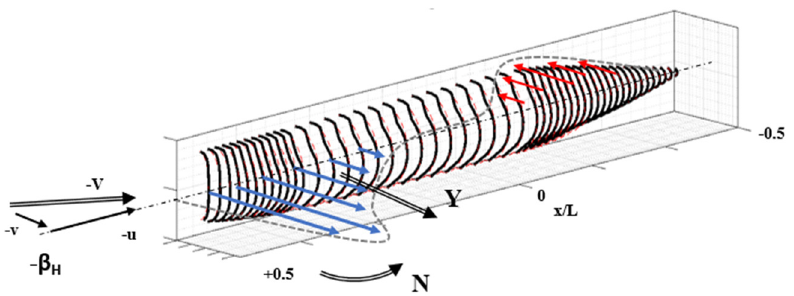
Figure 2. Bare hull—strip theory sectional forces.